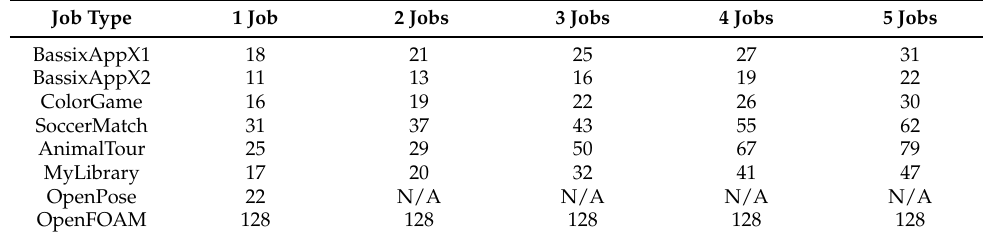
Table 5. Increasing CPU time at PC5 (s).